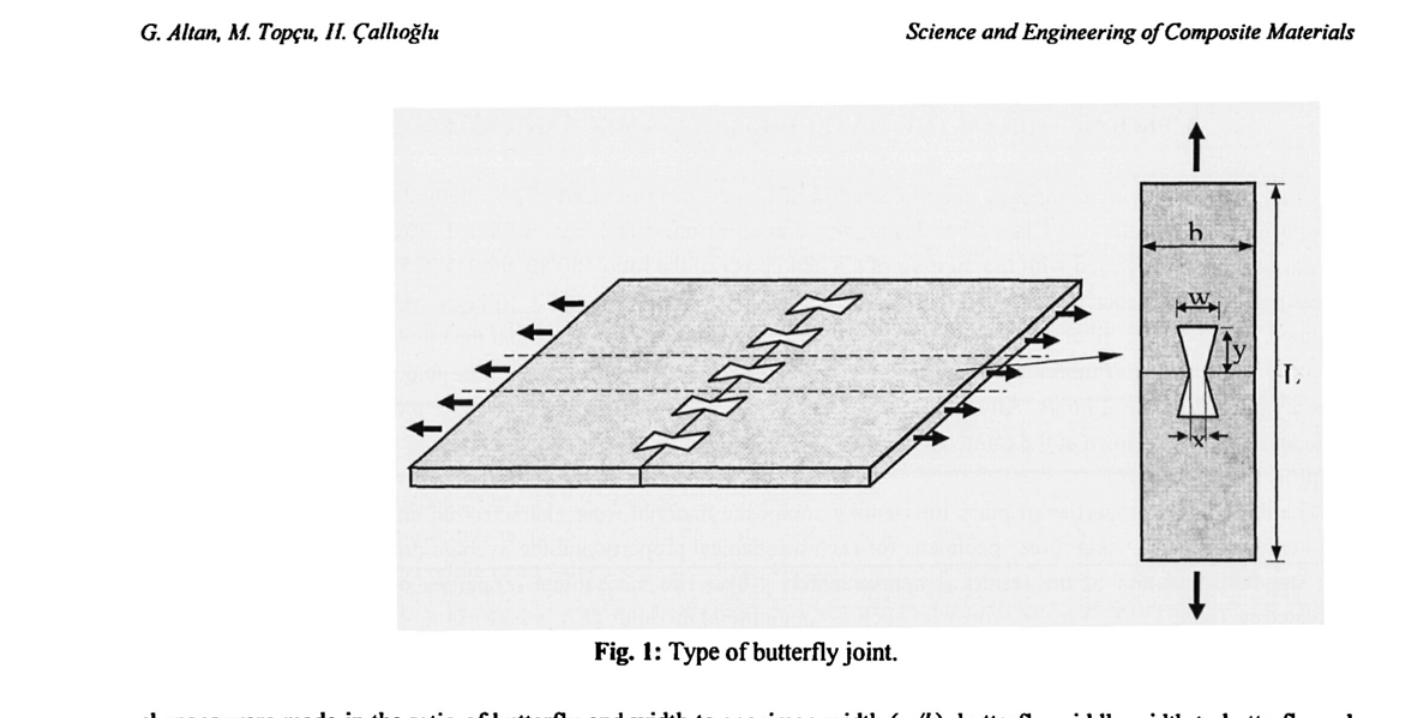
Fig. 1: Type of butterfly joint.